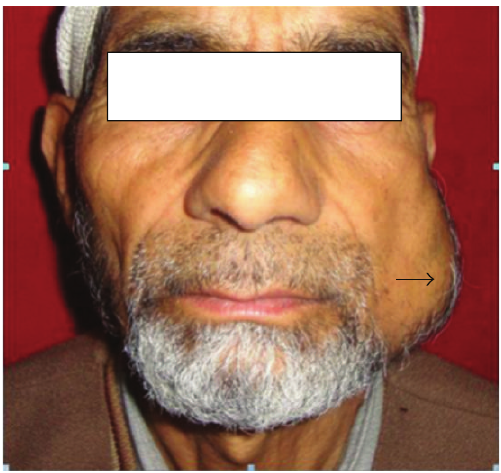
Figure 1: Clinical picture of the patient with one-month history of swelling in left mandibular region.